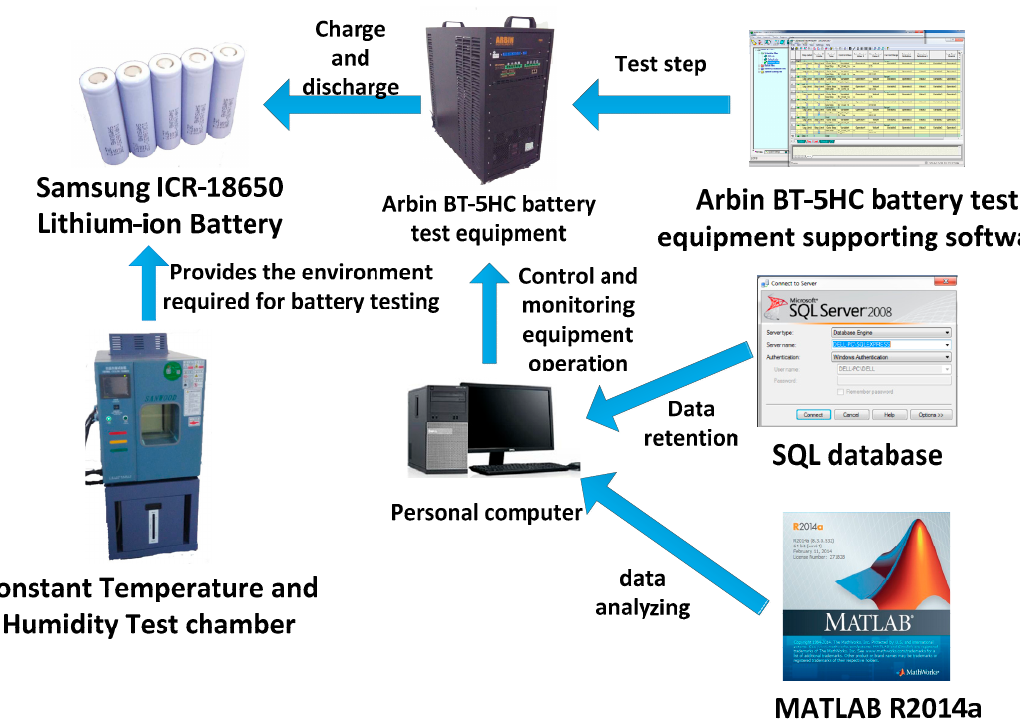
Figure 3. The structure of the battery test workbench.